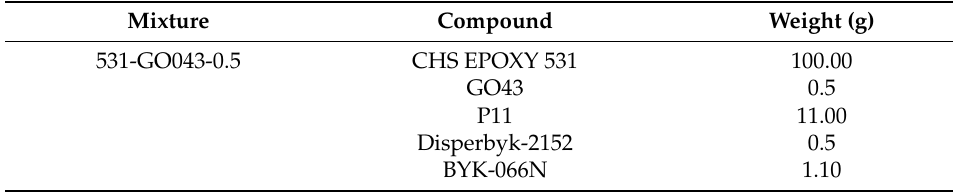
Table A16. Graphene oxide GO21 CHS Epoxy 531, 0.6 phr.